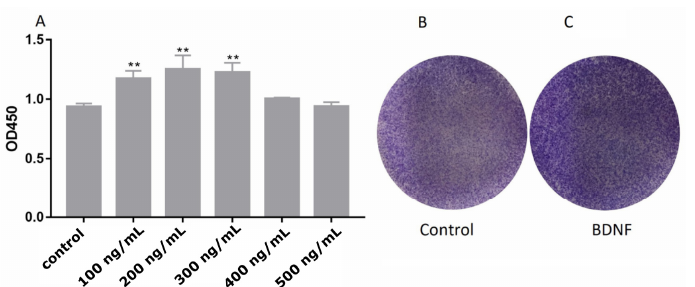
Figure 3. Brain-derived neurotrophic factor (BDNF) promoted Ishikawa cells’ viability and proliferation. ( A ) The viability of Ishikawa cells was measured by CCK-8 after treated with various concentrations of BDNF. BDNF significantly promoted Ishikawa cells viability at concentrations of 200 ng/mL. ( B ) Colony formation assay was used to evaluate cell proliferation in the control. ( C ) Colony formation assay was used to evaluate cell proliferation in the 200 ng/mL BDNF. Statistical analysis is shown. ** p < 0.01.